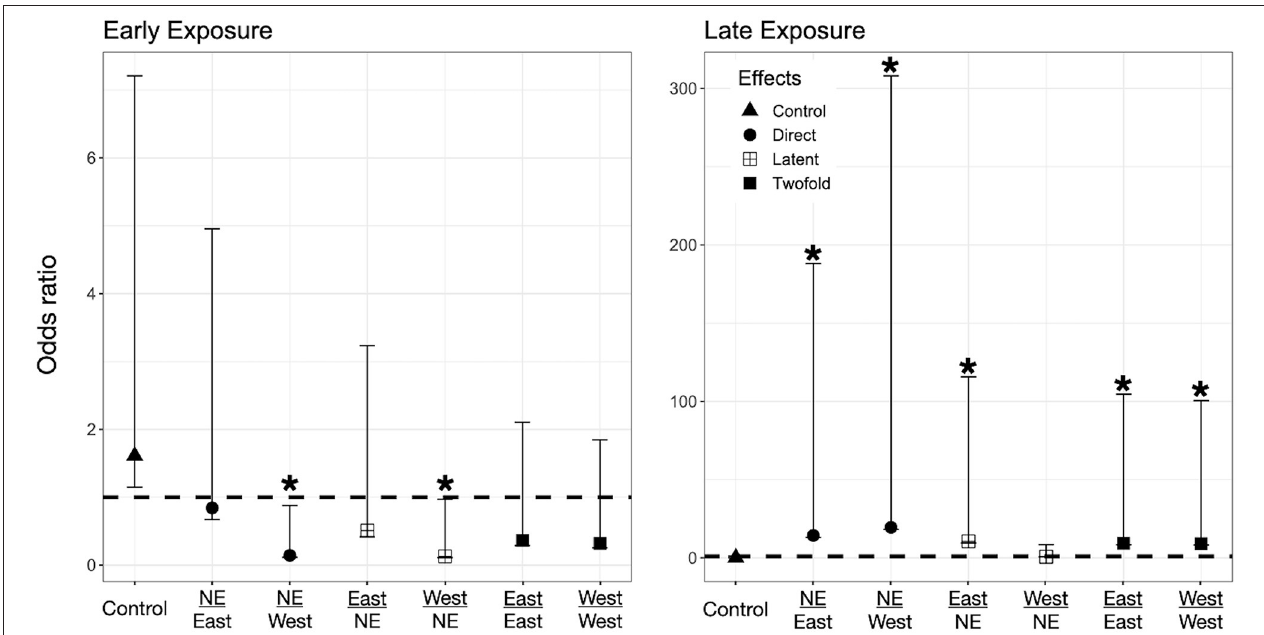
FIGURE 4 | Odds ratio (OR) for A. boreas tadpoles according to their exposure regimes. Label of x-axis includes a fraction that indicates in the numerator the exposure regime as embryo and in the denominator exposure regime post-hatching (no exposure = NE, East or West for Bd chytrid strain). A dashed line indicates value 1. OR > 1 higher risk after exposure, OR = 1 no risk difference, OR < 1 lower risk after exposure. A star (*) indicates treatments with significant odds ratios. Effects are represented as follow: Direct effects –only exposed to Bd as larvae– are represented by circles, latent effects –only exposed as embryos– are represented as four squares, and 2-fold effects –exposed as embryos and larvae– are represented with filled squares; controls are represented by